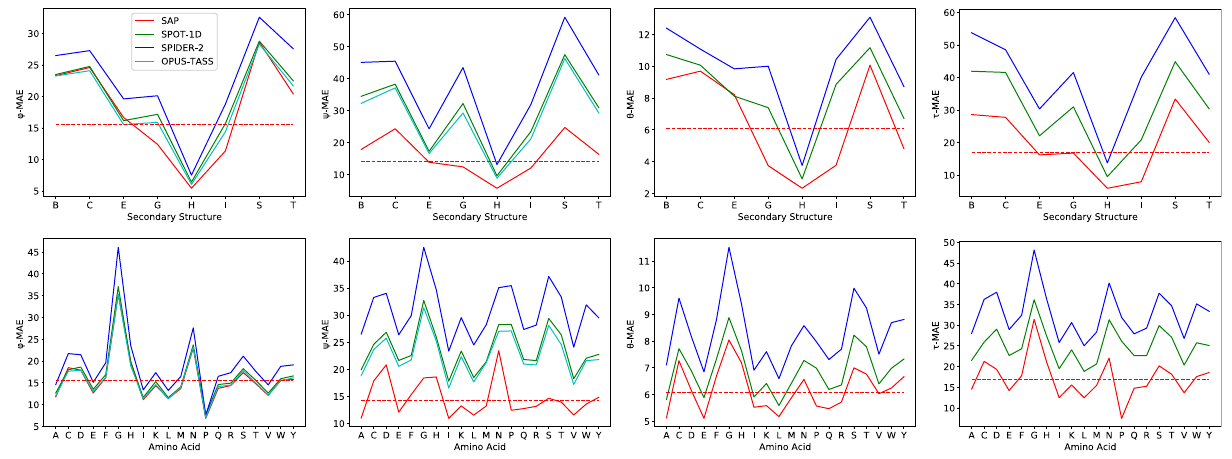
Figure 4. Performance of SAP, OPUS-TASS, SPOT-1D, SPIDER2 on the testing proteins when residues are grouped based (Top Four) on their SS types and (Bottom Four) on their AA types. In the charts, y-axis shows MAE values and x-axis shows SS or AA types. The dashed horizontal line in each chart shows the overall MAE value for SAP.